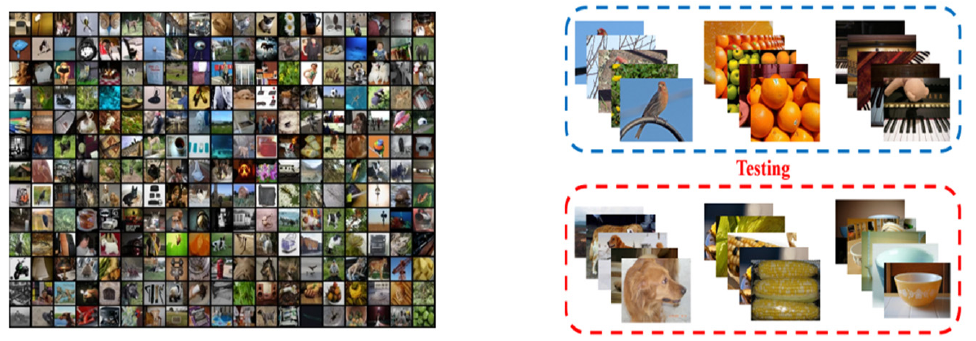
Figure 1. Example of few-shot training and classification.